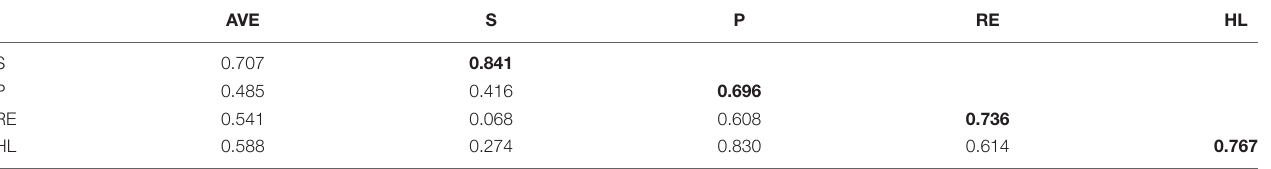
TABLE 3 | Discriminant validity.